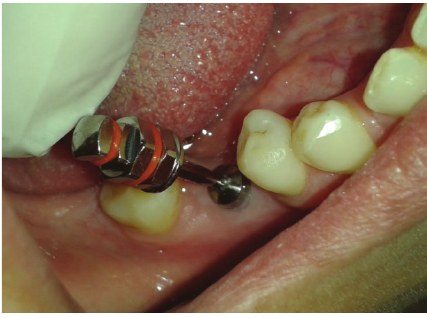
Figure 1: Healing abutment removed.